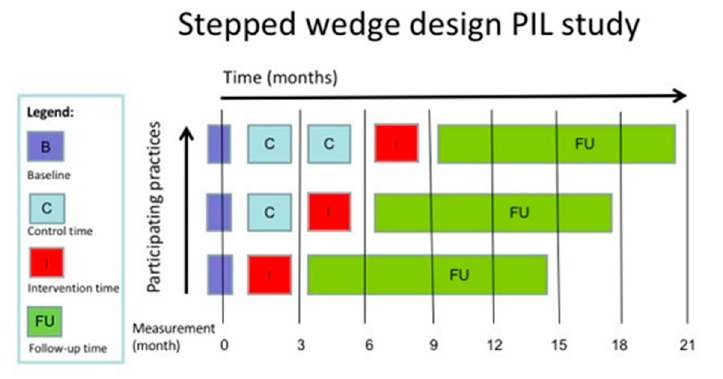
Figure 1. Flowchart stepped wedge design.